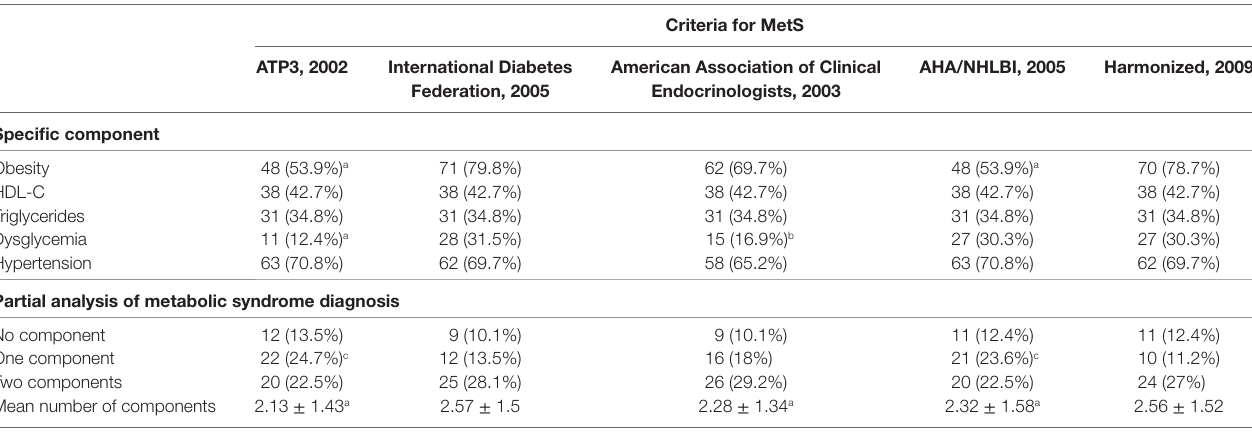
TaBle 8 | Individual component prevalence analysis for different metabolic syndrome (MetS) criteria.